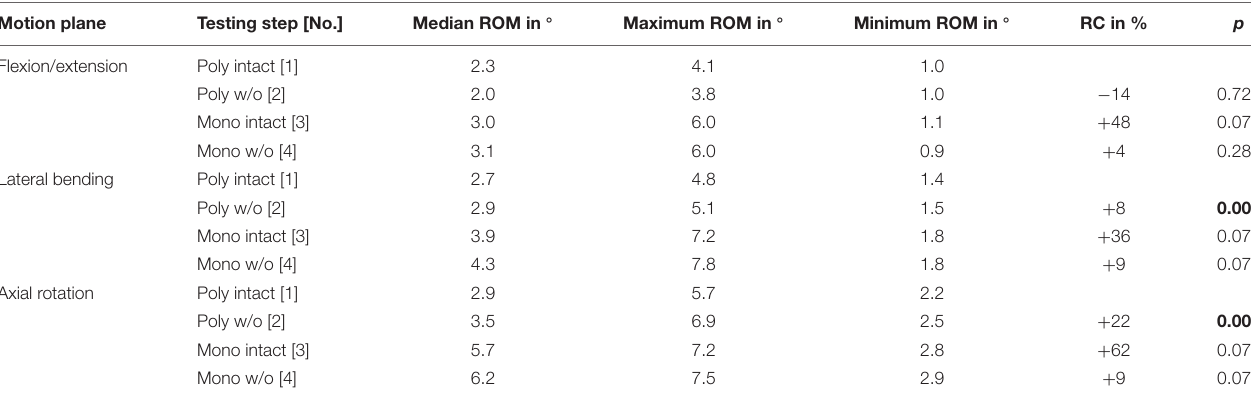
TABLE 8 | Results for T9-T10 range of motion at pure moments of ± 5 Nm ( n = 8) depending on primary motion plane and testing step. Motion plane Testing step [No.]